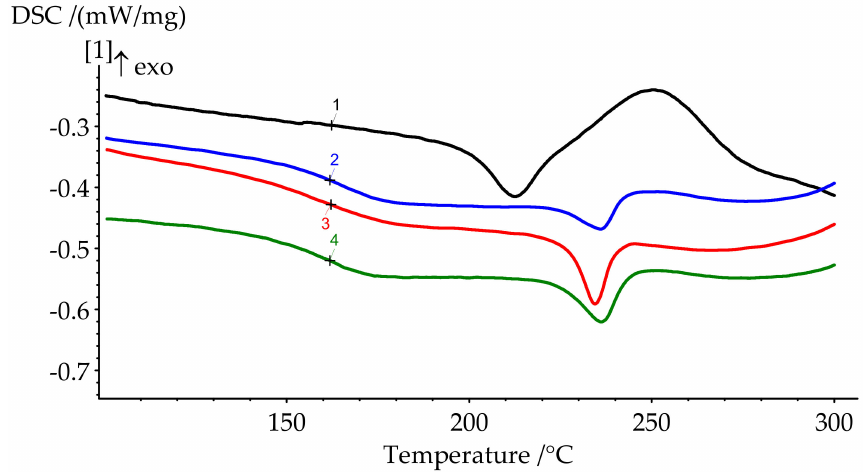
Figure 8. DSC curves of cured formulations 1–4.